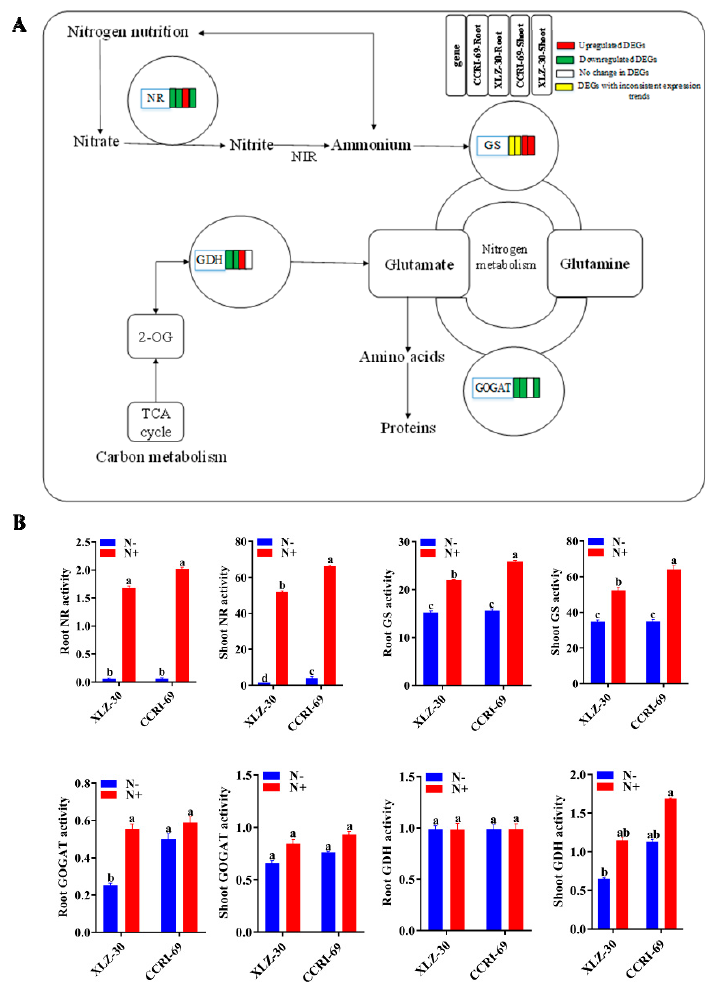
Figure 7. The DEGs of N metabolism pathway ( A ) and activities of key N assimilating enzymes ( B ) in the roots and shoots of CCRI-69 and XLZ-30 under N starvation and resupply treatments. The DEGs of the N metabolism pathway in the roots and shoots of CCRI-69 and XLZ-30 under N starvation and resupply treatments. The rectangles behind the gene, which were tagged with red, green, white, or yellow color, represent the upregulated DEGs, downregulated DEGs, unchanged DEGs, or the DEGs with inconsistent expression trend, respectively. N − , N starvation and N + , mean N resupply. NR, nitrate reductase ( µ g g − 1 FW h − 1 ); GS, glutamine synthetase ( µ mol g − 1 FW h − 1 ); GOGAT, glutamate synthase (U mg − 1 protein); GDH, glutamate dehydrogenase (U mg − 1 protein). Bars with different letters indicate significant difference ( p < 0.05).